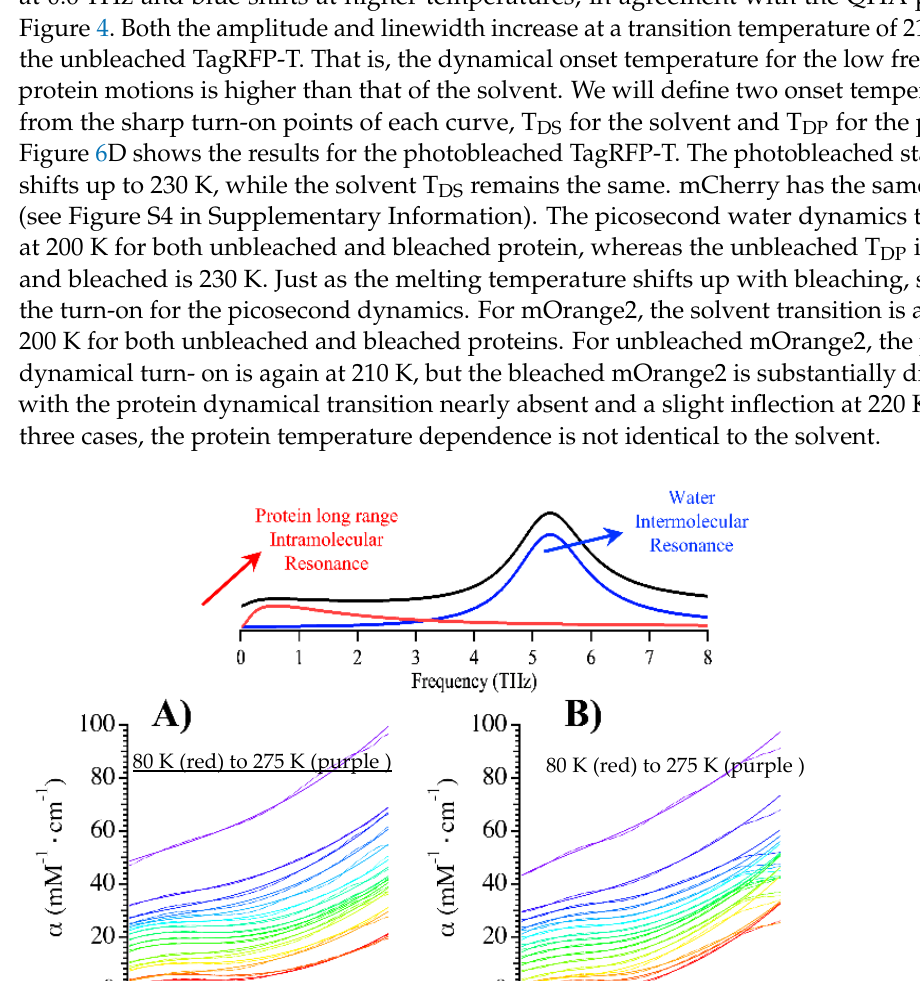
Figure 5. Comparisons of the frequency dependent THz molar absorptivity with resonance fitting lines for photoactive ( A ) and photobleached ( B ) TagRFP-T. The offset of 2 mM − 1 cm − 1 was applied to distinguish different temperatures, with the lowest temperature (80 K) in red and highest temperature (275 K) in purple. The top figure illustrates the decomposition of the absorption into two Lorentzian resonances: protein long-range intramolecular resonance centered at ~0.6 THz and larger-amplitude water intermolecular resonance at 5.3 THz.